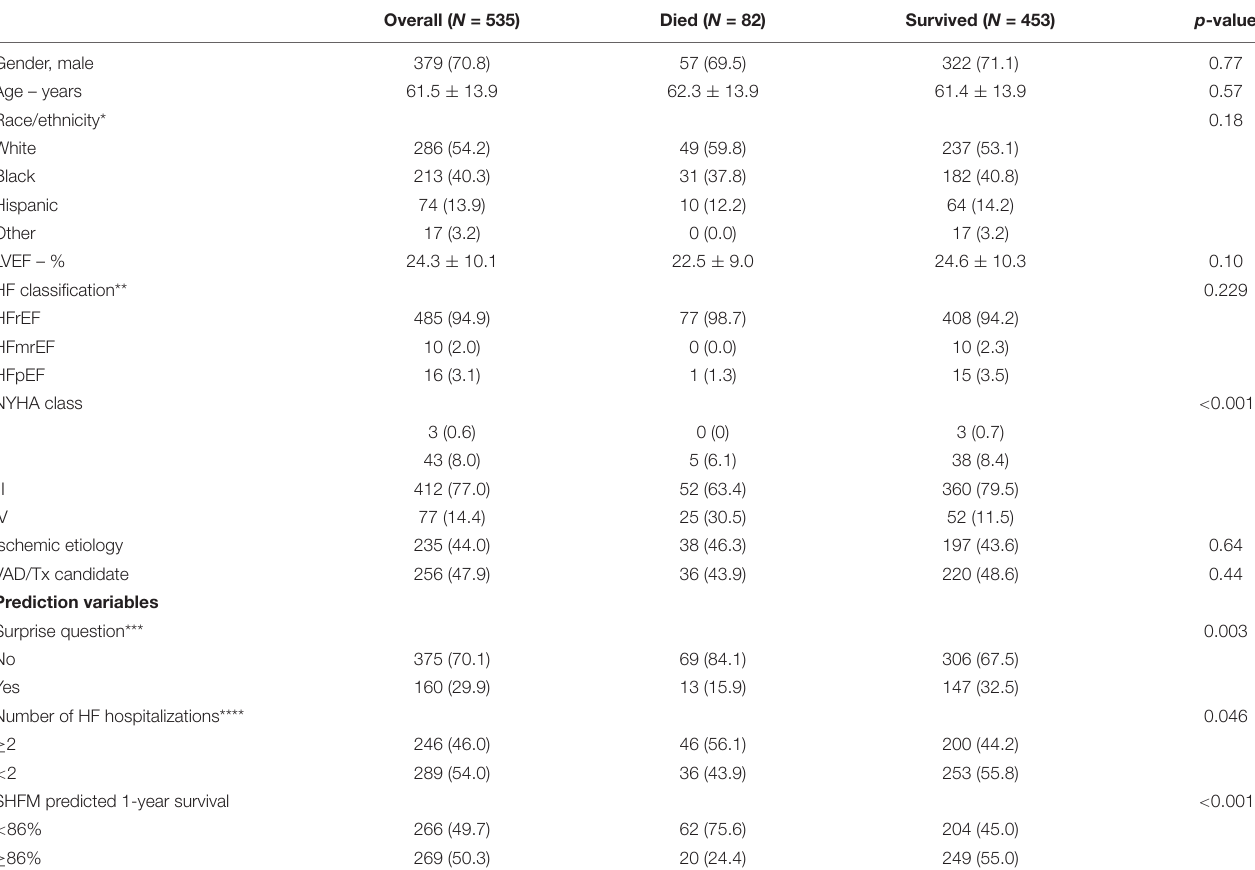
TABLE 1 | Baseline characteristics of the study population overall and stratified for survival status after 1-year follow-up. Overall ( N = 535) Died ( N = 82) Survived ( N = 453)